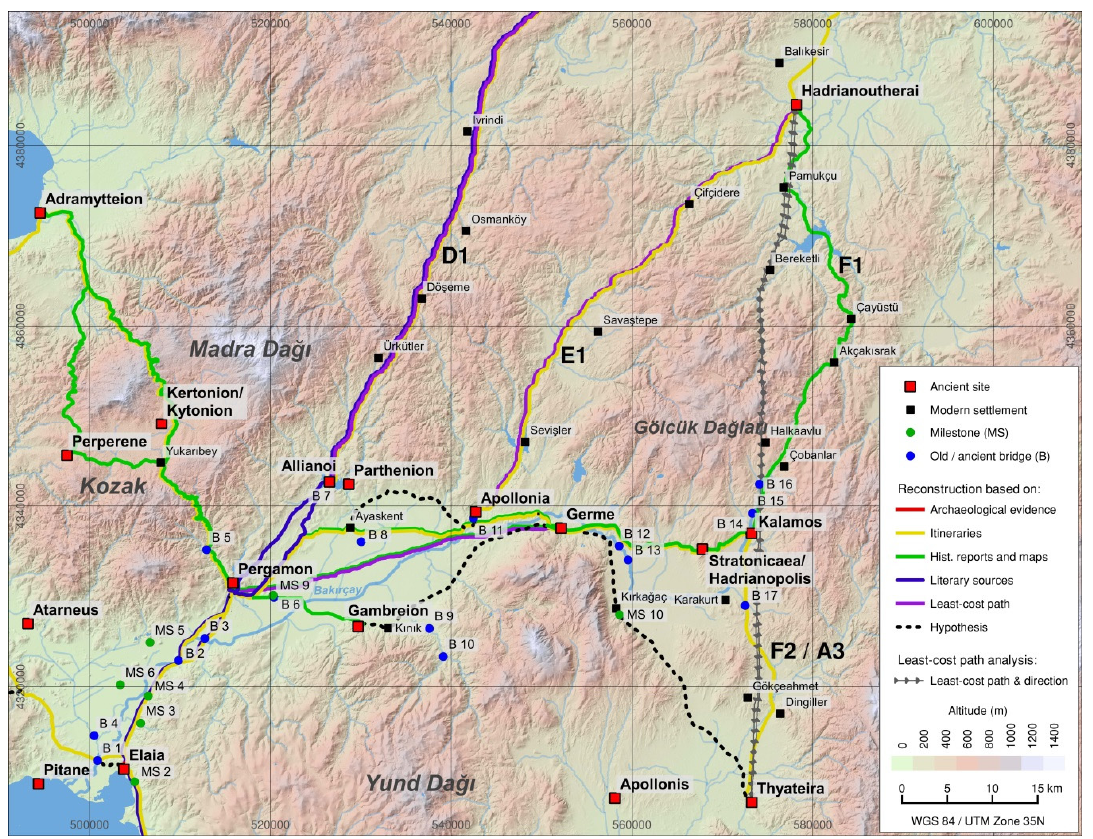
Figure 17. Calculated least-cost paths and reconstructed route between Hadrianoutherai and Thyateira via Kalamos.